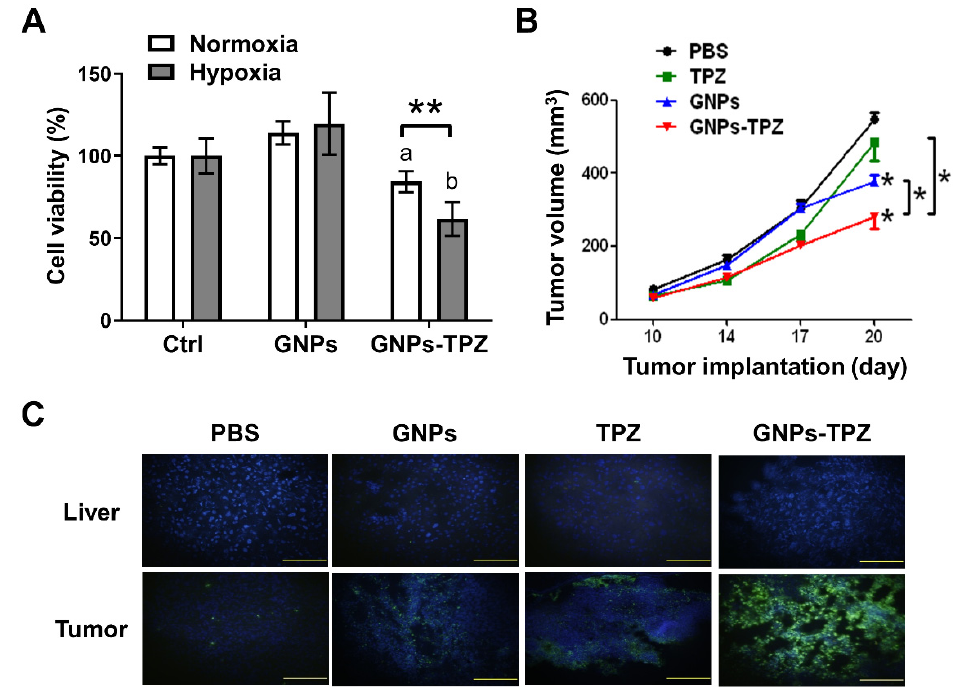
Figure 6. GNPs–TPZ treatment contributed to the reduction of MKN45 cell viability and tumor volume of MKN45 tumor-bearing xenografts. A significant reduction in cell viability of MKN45 cells cultured in medium containing GNPs–TPZ under hypoxia for 48 h compared to in normoxia ( A ). Cell viability was assessed by using WST-1 assay; ** p < 0.01 represented the statistical significance of cells receiving GNPs–TPZ treatment in hypoxia vs. normoxia. The lowercase letter “a” indicates statistical significance compared to control under normoxia, and the “b” indicates statistical significance compared to control under hypoxia. Changes in tumor volume in MKN45 xenografts post-intravenous injection of PBS, TPZ, GNPs, and GNPs–TPZ at the dose of 0.5 mg/kg ( n = 3 for each group) for 20 days were monitored and compared. As implanted tumors reached 50 mm 3 , drug injections were carried out at days 10, 14, and 17 ( B ); * p < 0.05 represented statistical significance among the labeled groups. Histological apoptosis detections in tumor and liver tissues resected from xenografts post-treated with PBS, Free GNPs, TPZs, and GNPs–TPZ by TUNEL staining. Green, apoptosis DNA; blue, cell nuclei. Scale bar: 100 μ m ( C ).